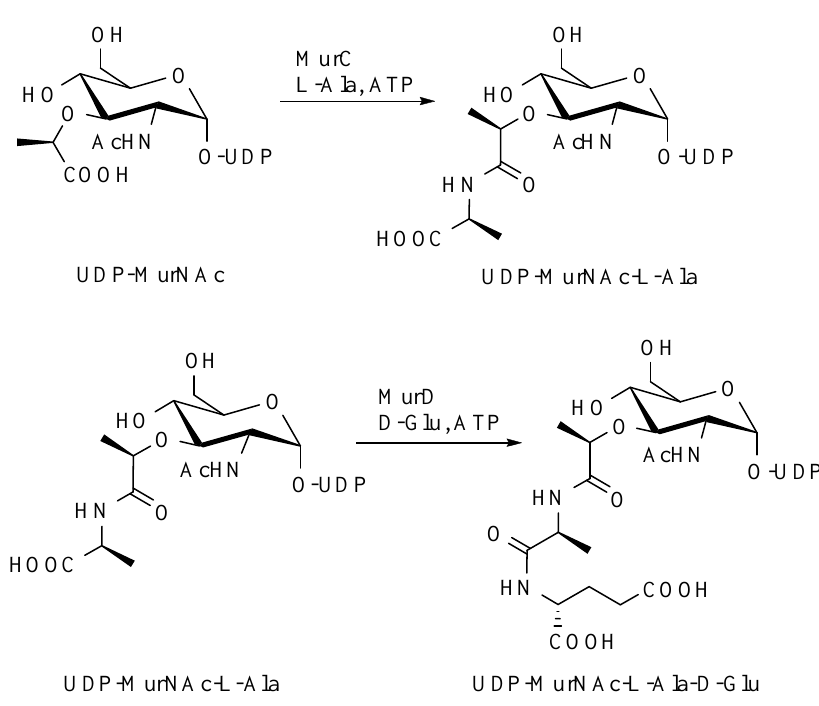
Figure 1. Reactions catalyzed by MurC and MurD